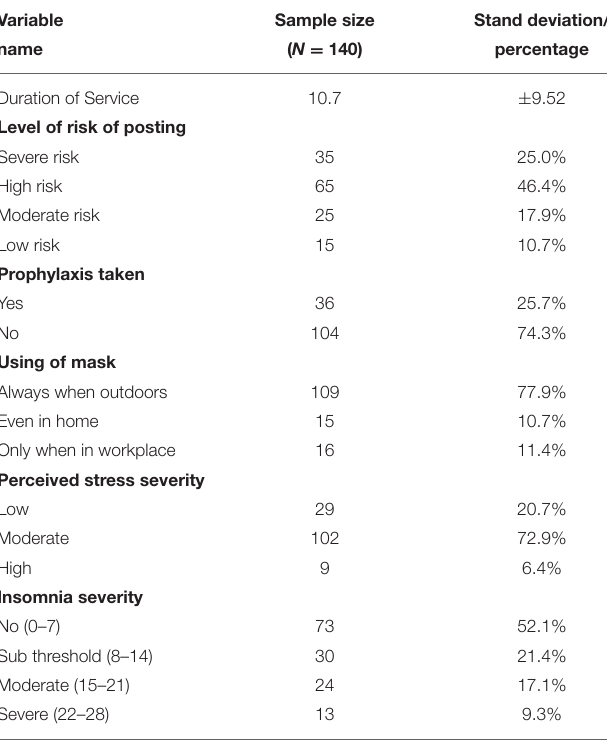
TABLE 2 | Clinical-professional details of the participants.